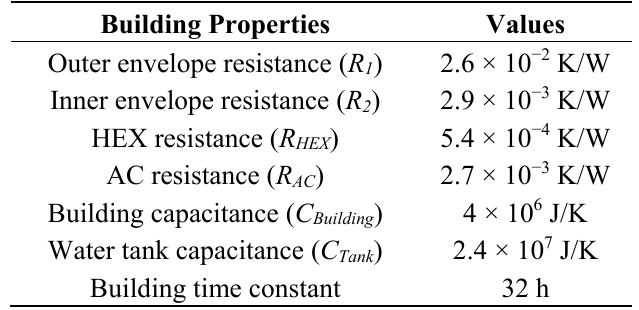
Figure 1. Reference building circuit. Table 1. Building properties for a single room with brick cavity brick walls.